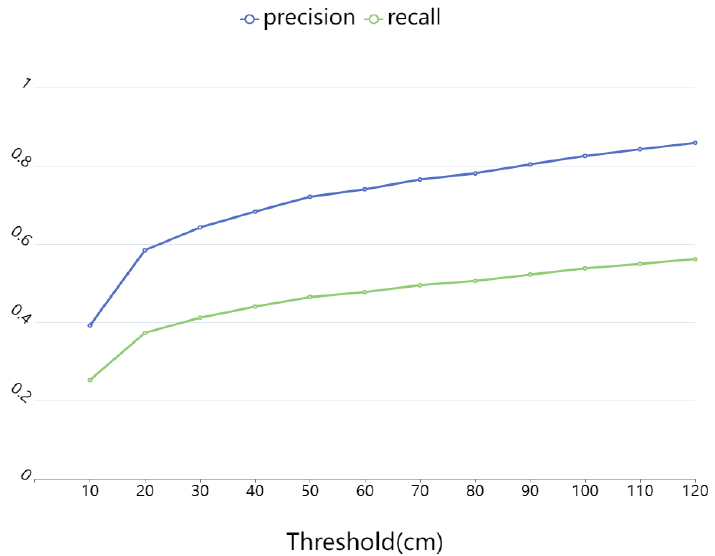
Figure 8. Precision and recall of our method with different distance thresholds on GibLayout